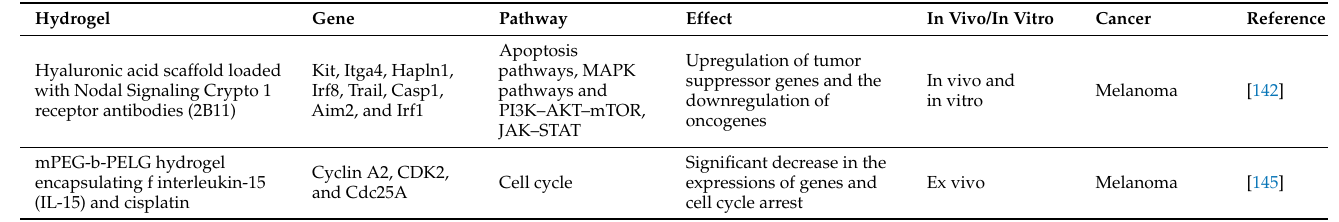
Table 3. Recent studies on the gene regulations upon hydrogel-based drug delivery system for skin